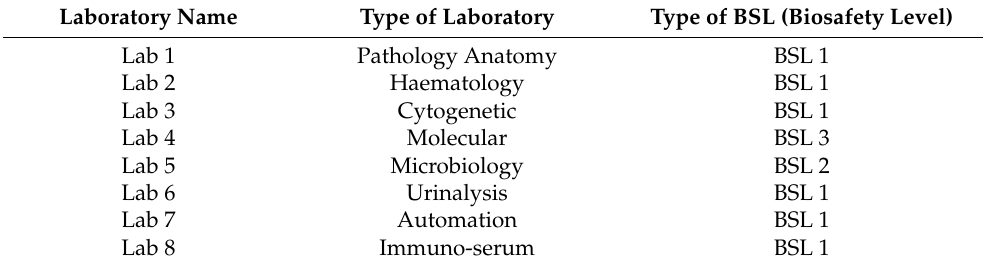
Table 1. Eight laboratories of the National Clinical and Medical Referral Centre